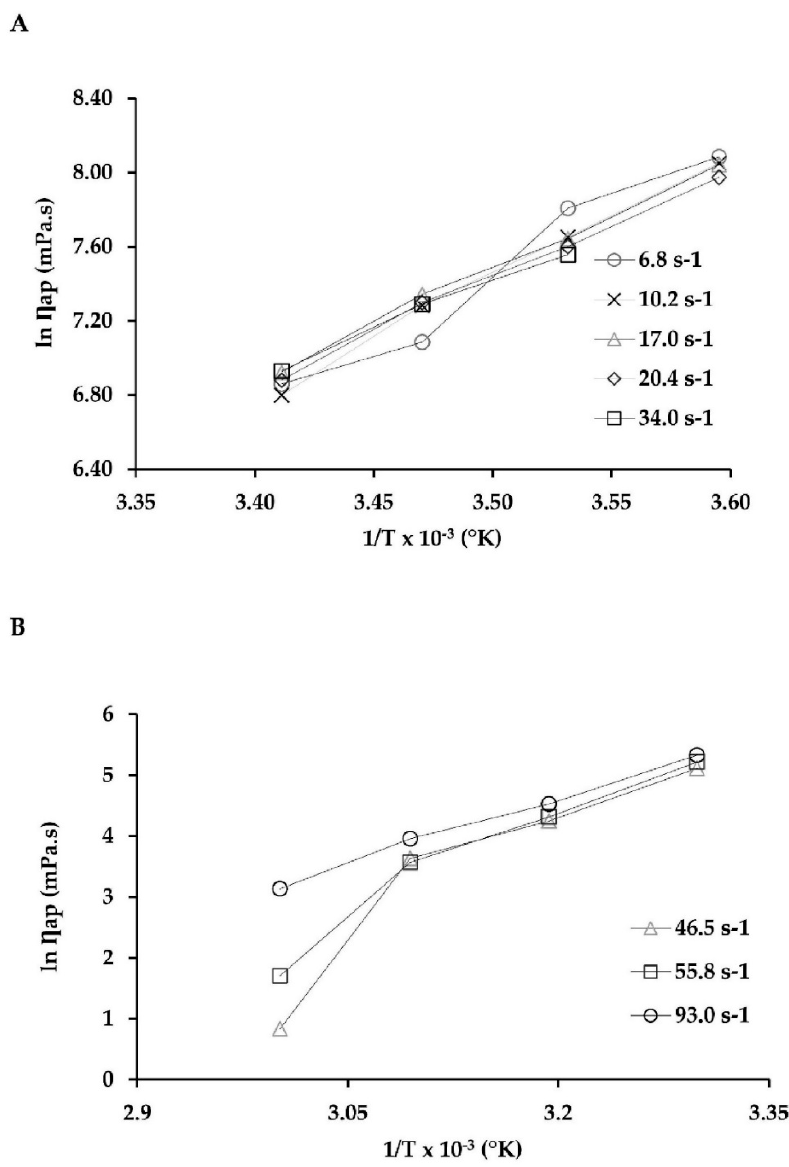
Figure 3. Temperature e ff ect on the apparent viscosity of oleoresin at di ff erent shear rates. ( A ) Low temperatures from 5 to 20 ◦ C (with spindle SC–21; n = 3) and ( B ) high temperatures from 30 to 60 ◦ C (with spindle SC–27; n = 3). Table 4. Parameters of the Arrhenius equation for the oleoresin extracted by SC-CO 2 from the microalga Haematococcus pluvialis at low temperatures (5–20 ◦ C).